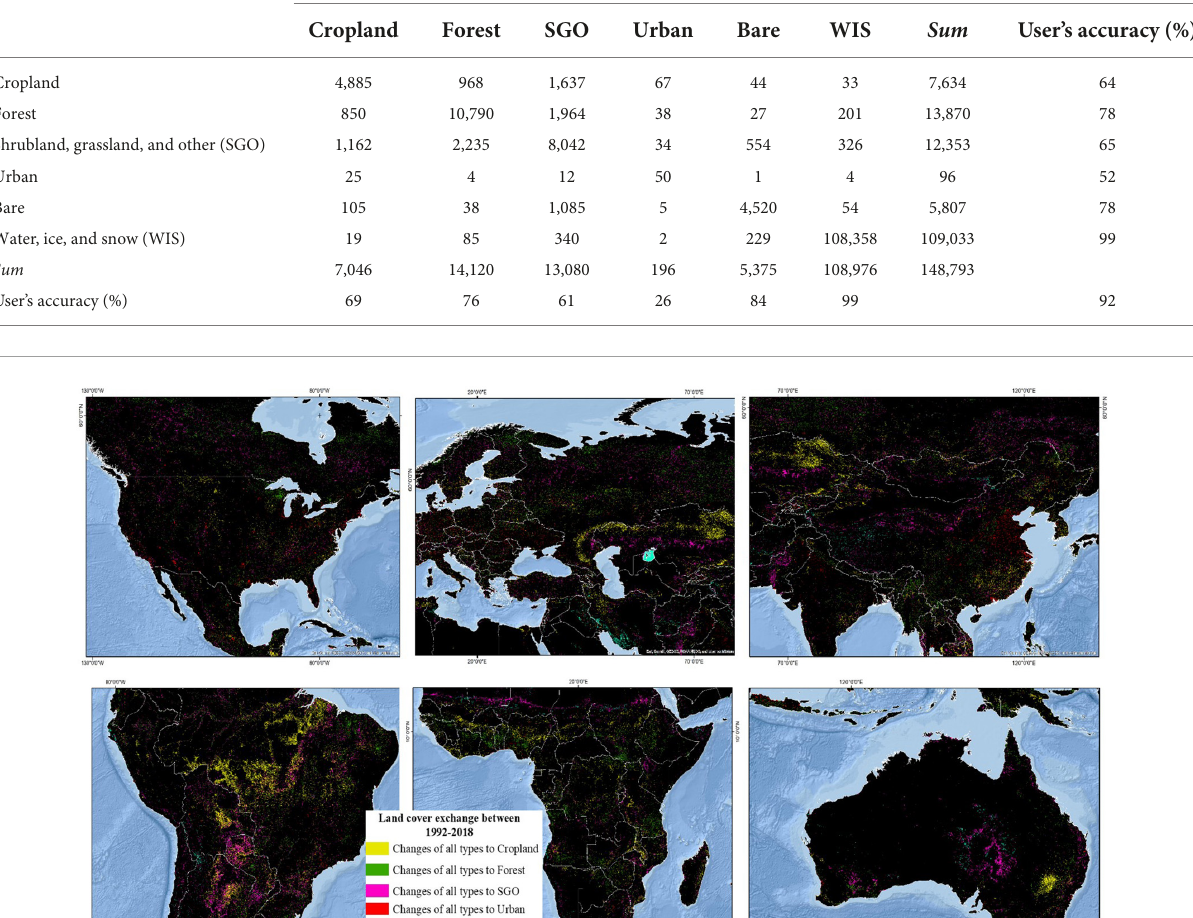
represent the area of land that has undergone each transition, are expressed in square kilometers relative to the total area of land globally that changed land cover type over the study period. Globally, the largest transition is 1194912.4 km 2 (17%) for the conversion of Forest cover to Cropland, followed by 651492.5 km 2 (9.3%) for the conversion of Cropland to Forest cover, and 286650.4 km 2 (4.1%) for the conversion of Cropland to